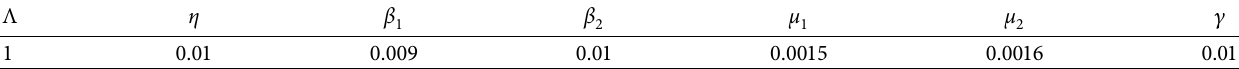
Table 1: System parameters.